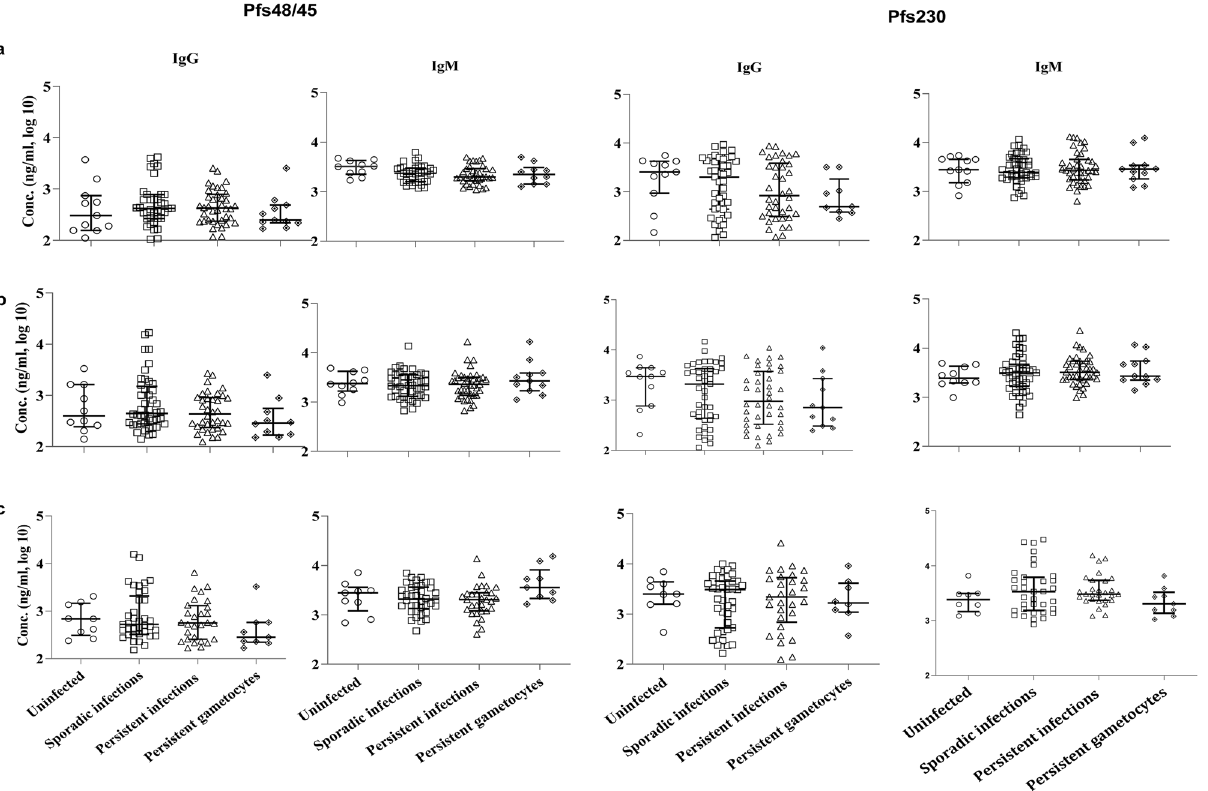
Figure 3. Antibodies against gametocyte antigens Pfs48/45.6C and Pfs230proC over the course of the study. Infectivity status did not influence the concentrations of IgG and IgM antibodies against gametocyte antigens, Pfs48/45.6C and Pfs230.proC. IgG and IgM antibodies levels (ng/ml, log 10) specific for gametocyte antigens, Pfs48/45.6C and Pfs230.proC were measured monthly [days 14 ( a ), 42 ( b ), and 70 ( c )] in plasma from all the participants. The antibody concentrations obtained at each time point are plotted in groups based on overall infectivity status, uninfected (n = 11), sporadically infected; ≤ 4 infections (n = 49), persistently infected; ≥ 5 infections (n = 39), and persistent gametocytes; ≥ 5 episodes (n = 11) of gametocytemia. The median and interquartile range of the antibody concentrations are shown and differences between groups were analyzed by one-way ANOVA. The p values (p = 0.0631–0.994) are listed in Supplementary Table